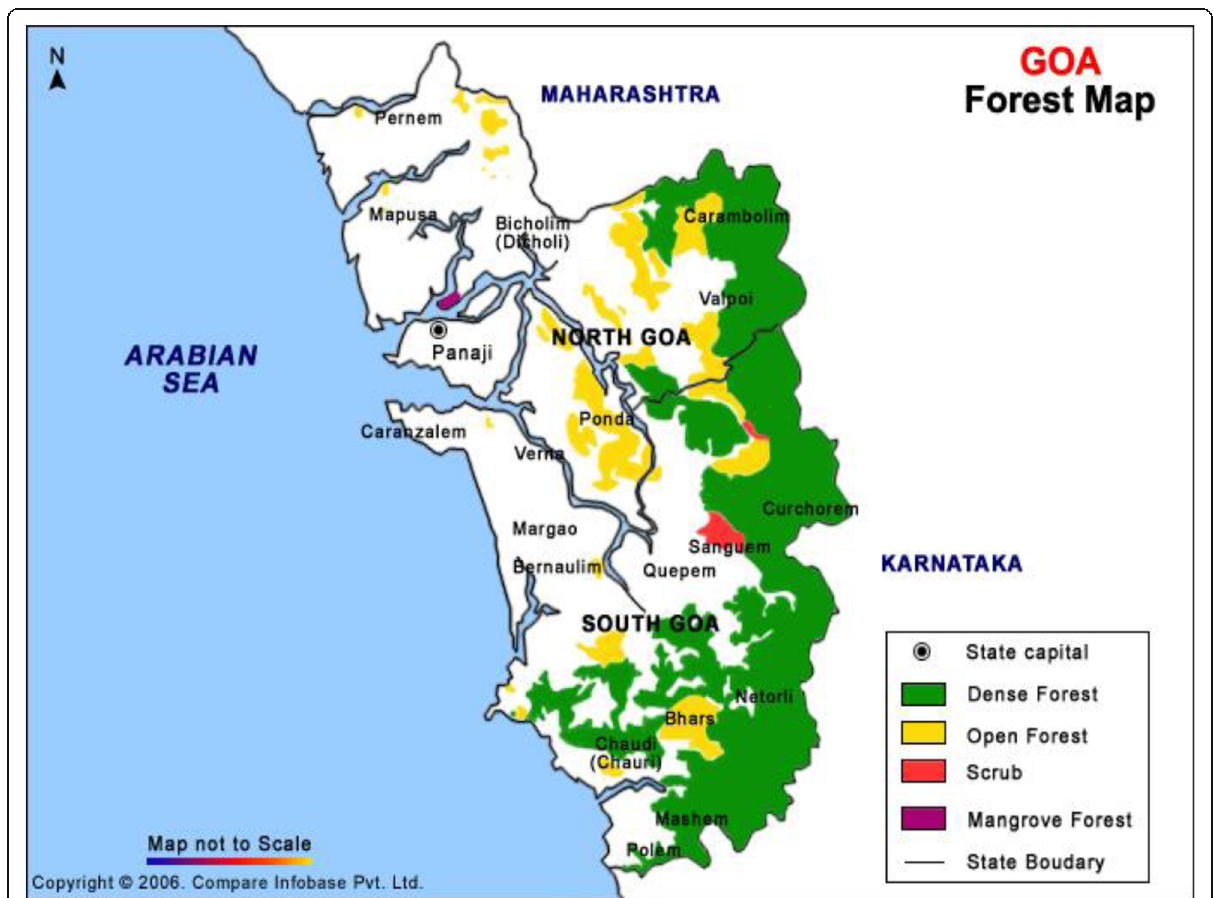
Fig. 1 Forest map of Goa showing the distribution and type of